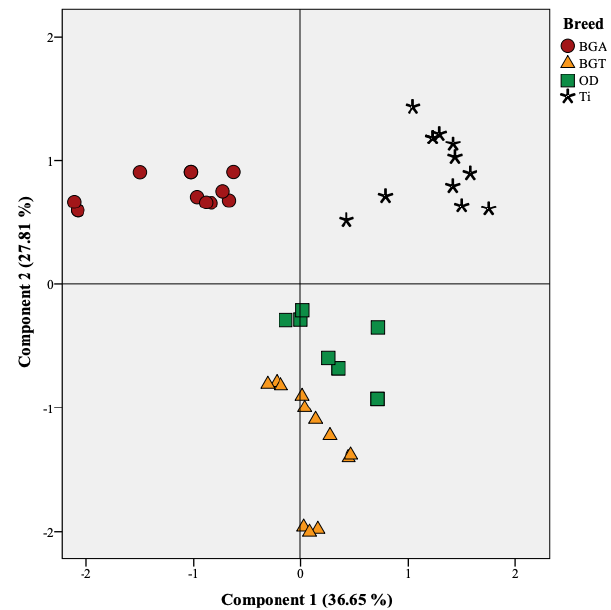
Figure 2. Projection of the variables of the four studied meats in the plane defined by two principal components; BGA: female lambs of Beni Guil sheep breed sampled in the Ain Beni Mathar region; BGT: female lambs of Beni Guil sheep breed sampled in the Ten- drera region; ODj: Ouled Djellal sheep breed; Ti: Timahdite sheep